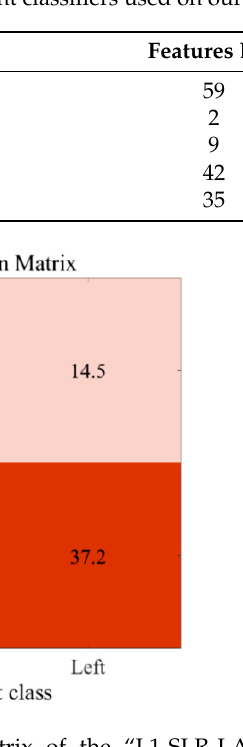
Figure 7. Confusion matrix of the “L1-SLR-LAP” classifier to distinguish the MI of left- and